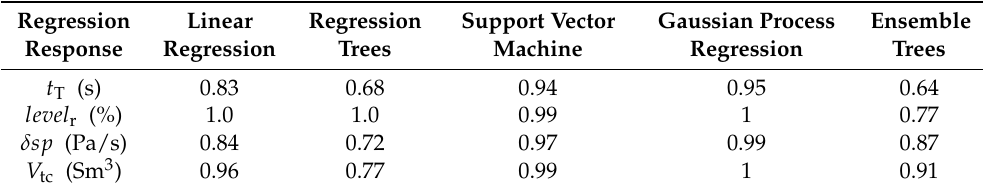
Table 3. Comparison of the R-squared of surrogate